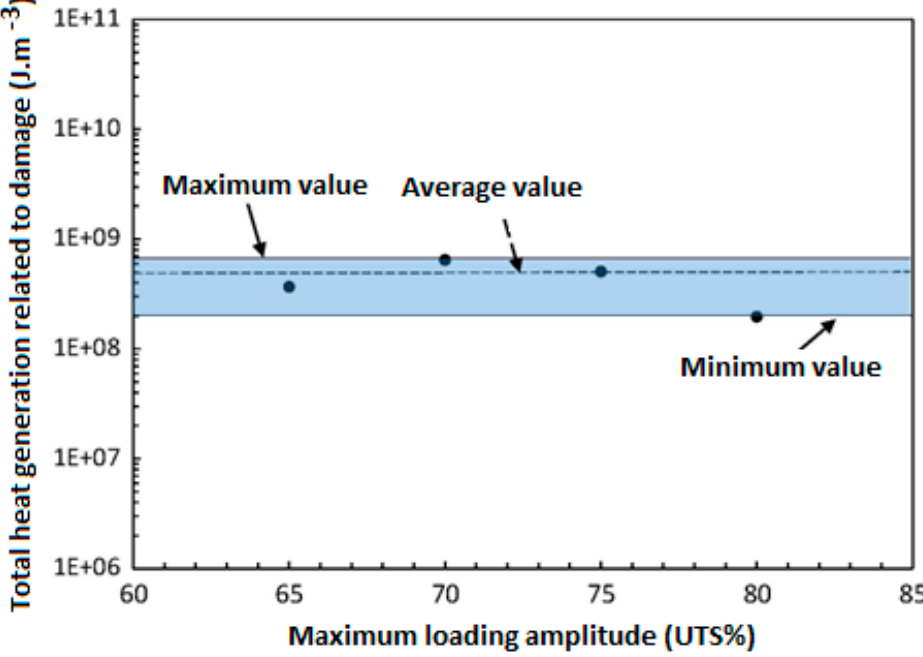
Figure 61. The exemplary heat generation plot for CFRP composite induced by damage over the entire fatigue life, adapted with permission from Ref. [89]. Copyright © 2020 Elsevier